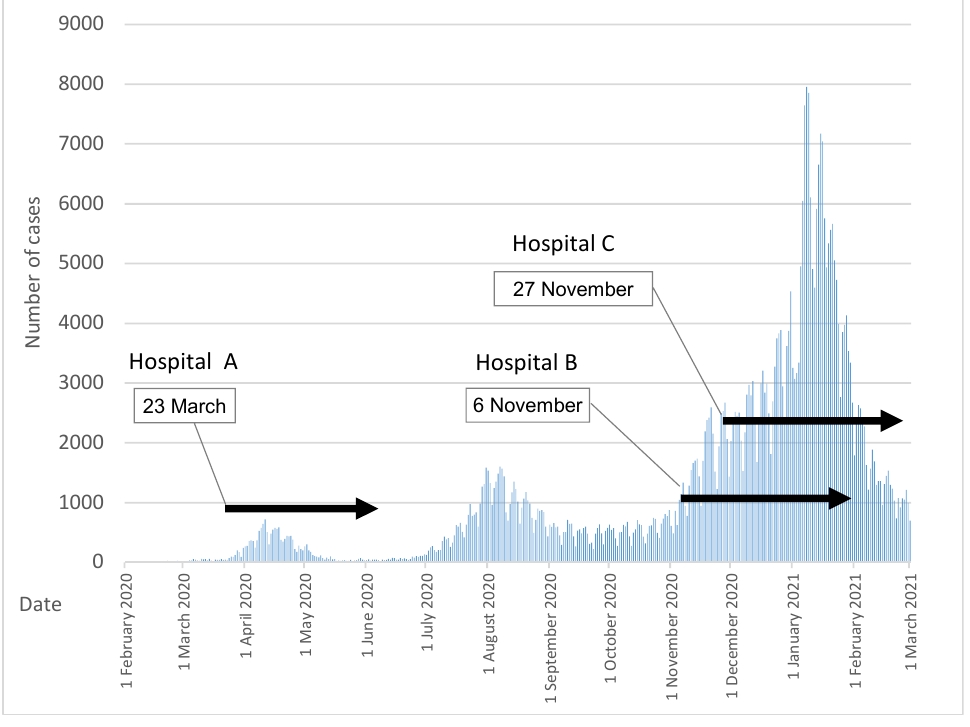
Figure 1. Spread of COVID-19 infection and the timing of the three hospital’s outbreaks. Au- thors made based on https://www.mhlw.go.jp/stf/covid-19/kokunainohasseijoukyou.html#h2_1, accessed on 1 April